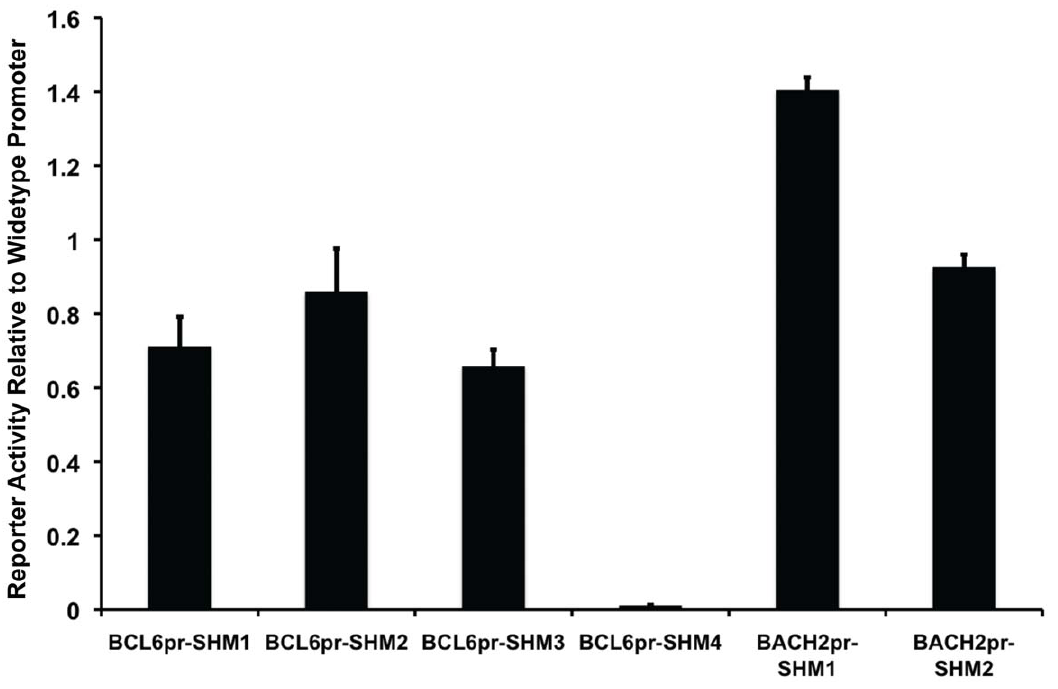
Figure 4. Aberrant SHMs affect promoter activity. The effects of selected SHMs on BCL6 or BACH2 promoter activities were tested by dual luciferase assay in OCI-Ly1. Reporter activity of promoter bearing individual SHM was normalized to reporter activity of the wild-type promoter. Error bars indicate standard errors of three independent experiments.